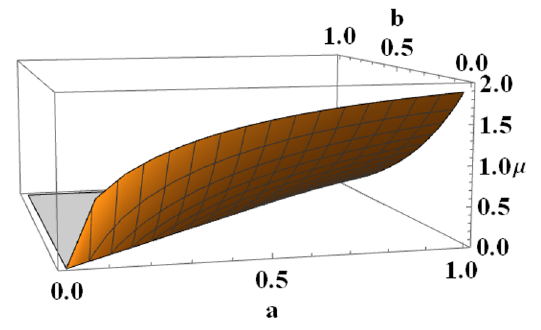
Figure 11 . The chemical potential µ as a function of the black hole parameters a and b , for ϕ 0 = 0 . The maximum is achieved at ( a, b ) = (1 , 0) . We plot only a ≥ b , the mirror for a ≤ b (the grey area) follows from antisymmetry of µ ( a, b ) under a ↔ b